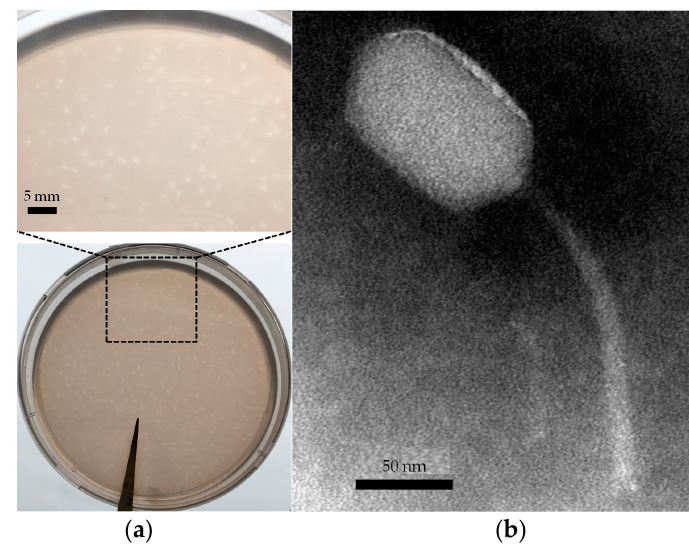
Figure 1. ( a ) Plaques and ( b ) transmission electron microscopy image of phage R5C.